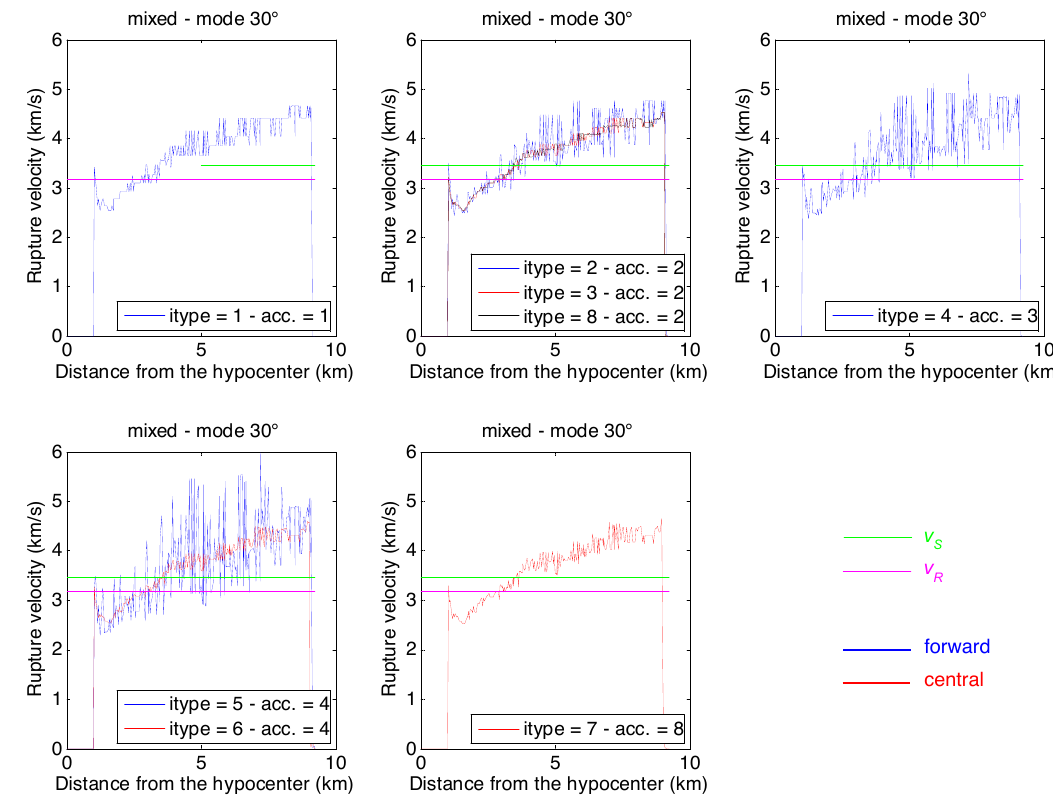
Figure 5. The same as in Figure 2, but now for a mixed–mode profile, having an azimuth angle of 30° with respect to the x